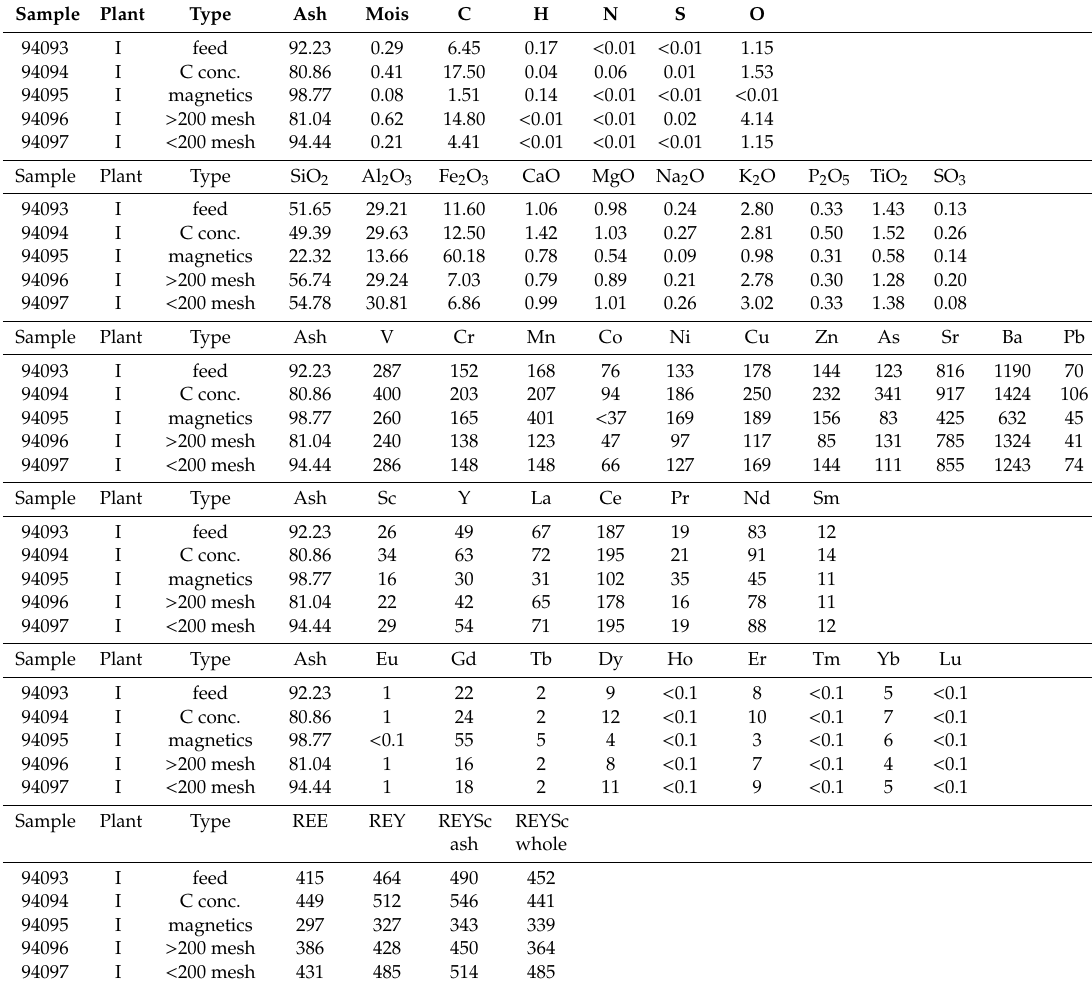
Table 2. Chemistry of fly ash fractions. Run 42 / Plant